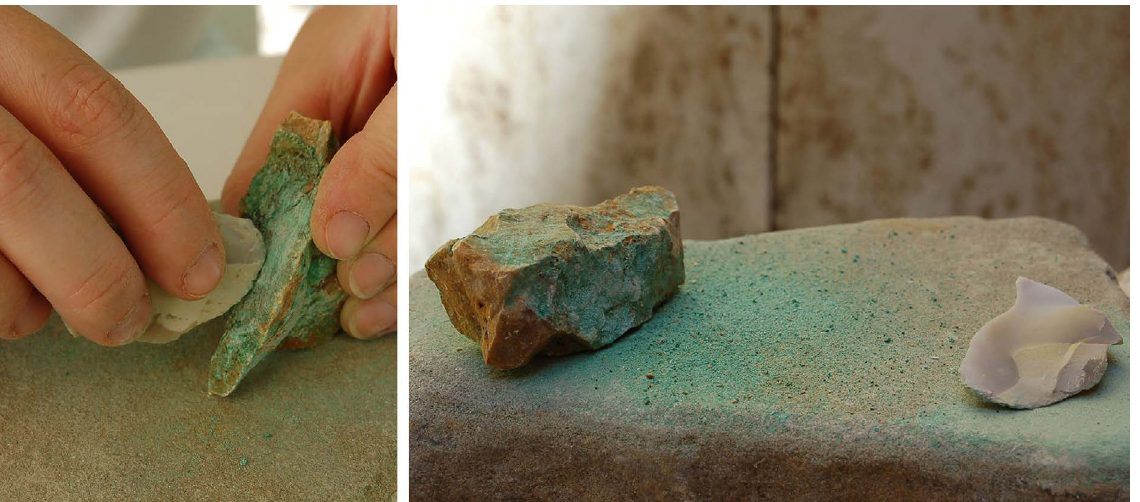
Figure 6. Experimentation on